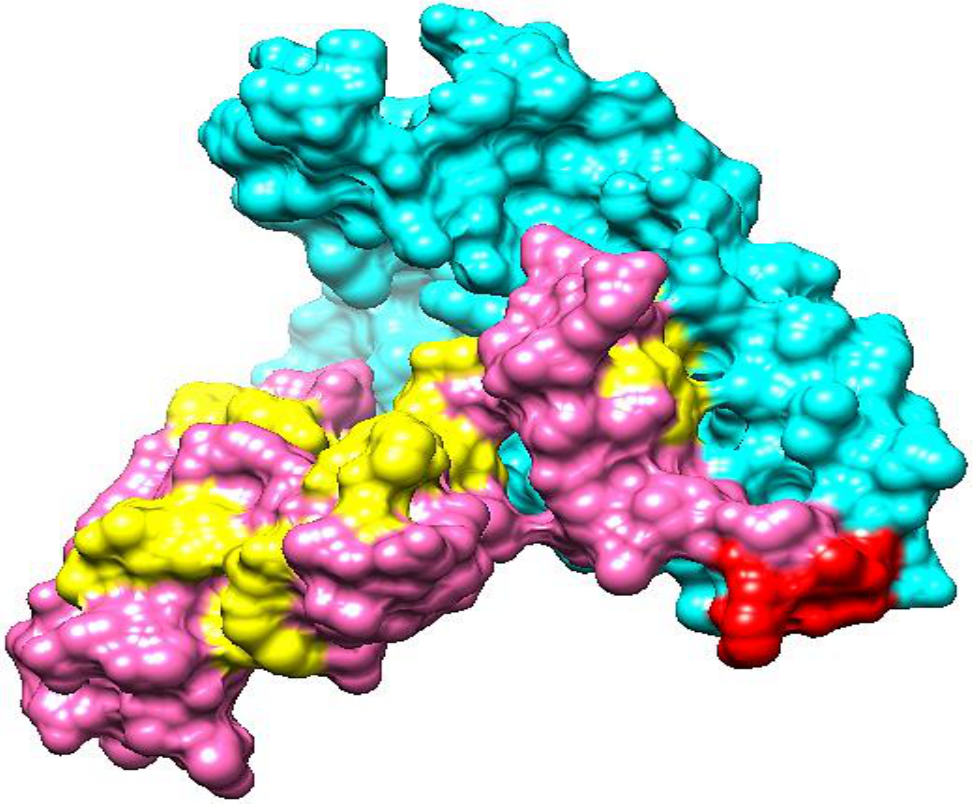
Figure 7. The 3D structure of a candidate vaccine construct. The cyan, red, pink, and yellow colors represent adjuvant, EAAAK linker, epitopes and GPGPG linkers, respectively.